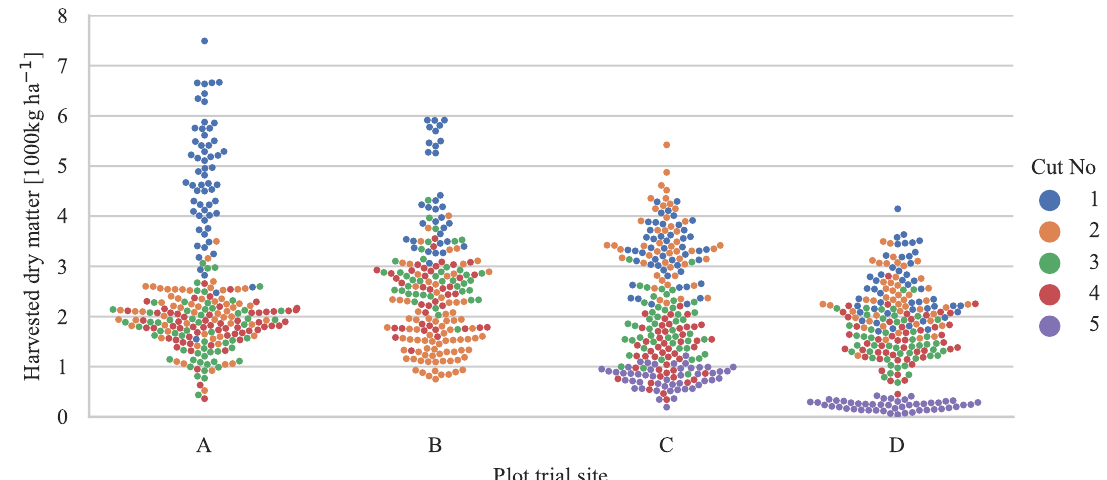
Figure 1. Distribution of biomass samples across quantity, plot trial site, and seasonal cut number. The harvested yield is based on the sampled area of 0.25m 2 per biomass